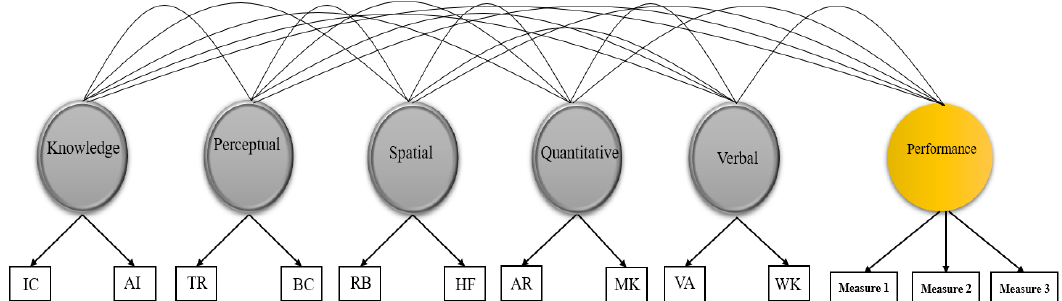
Figure 2. Representation of combined correlated-factor model containing cognitive abilities and performance measures. Note: VA = Verbal Analogies; WK = Word Knowledge; AR = Arithmetic Reasoning; MK = Math Knowledge; RB = Rotated Blocks; HF = Hidden Figures; TR = Table Reading; BC = Block Counting; IR = Instrument Comprehension; AI = Aviation Information. Performance presented here is latent, as is that modeled in pilot and navigator samples. Table 4. Correlations between cognitive abilities and job performance. Flying